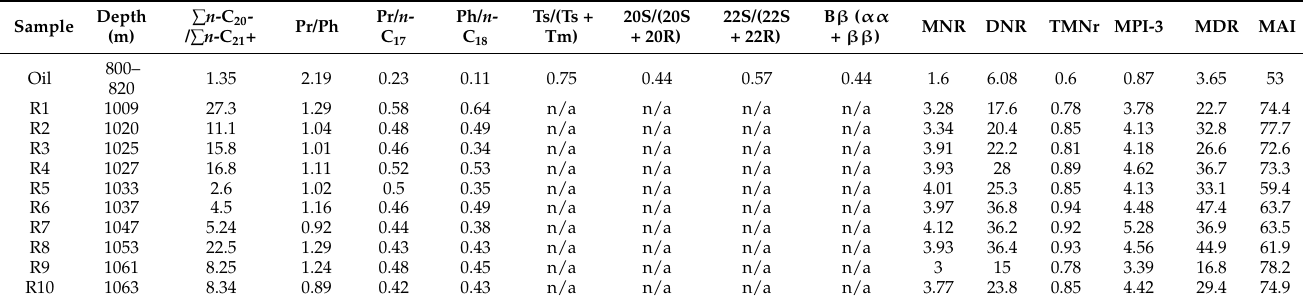
Figure 3. Representative chromatograms of m / z 85 showing typical distributions of n -alkanes and isoprenoids: ( a ) source rock extracts from well Chaiye 2 at a depth of 1009 m; ( b ) source rock extracts from well Chaiye 2 at a depth of 1033 m; ( c ) crude oil from well Chaiye 2. Table 4. Geochemical parameters of oil and source rock samples from well Chaiye